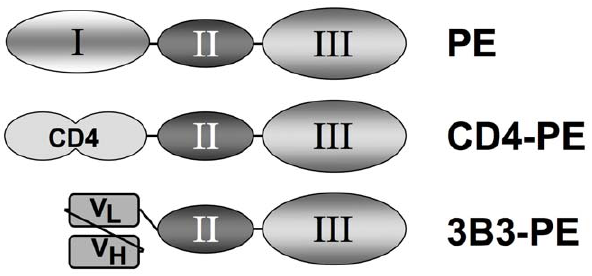
Figure 1. Schematic of Env-targeted toxins based on Pseudomonas exotoxin A. The immunotoxins are based on the domain organization of native PE (top). The N-terminal segment (domain I) is involved in binding to a surface receptor (members of the low density lipoprotein receptor-related protein 1 family), the central region (domain II) facilitates membrane translocation of the toxin into the cytoplasm, and the C-terminal segment (domain III) catalyzes ADP-ribosylation of elongation factor 2, resulting in shut-down of protein synthesis and cell death. In the recombinant single chain immunotoxins, domain I is replaced by a targeting moiety directed at HIV-1 gp120: soluble CD4 first two domains (CD4-PE, middle), or the 3B3 SCFv (3B3-PE,